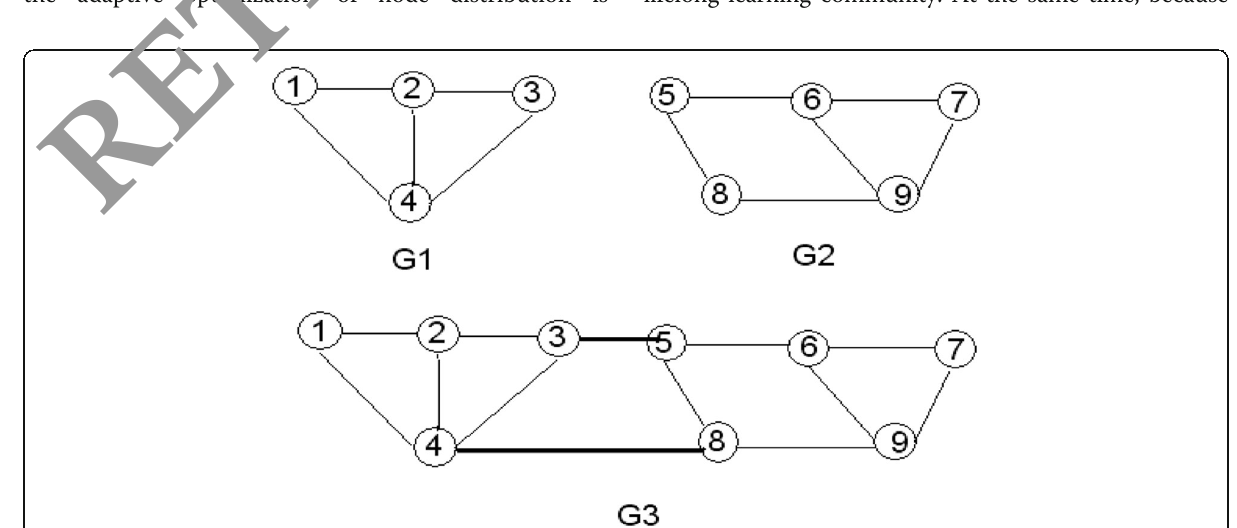
Fig. 3 Node overlay connected graph of SNS network